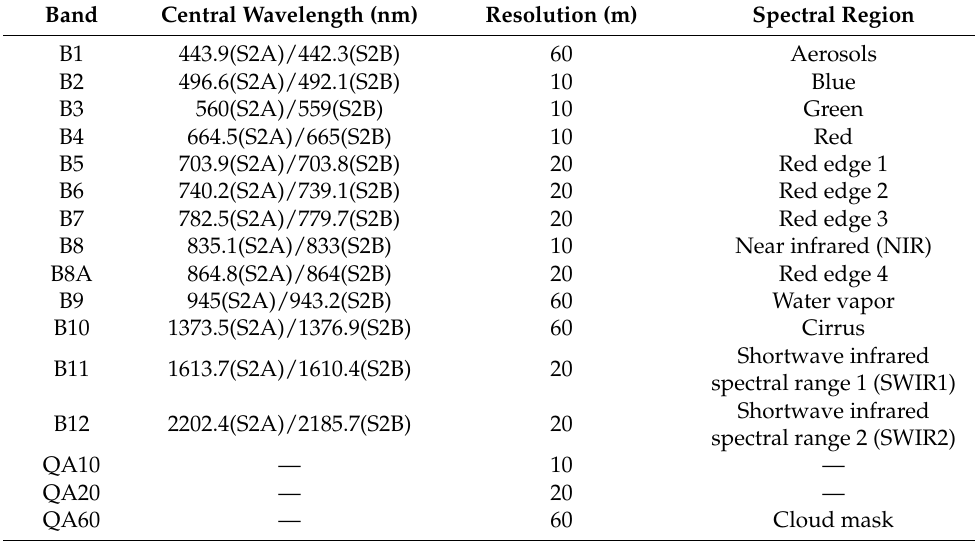
Table 1. Spectral bands of Sentinel-2 imagery.